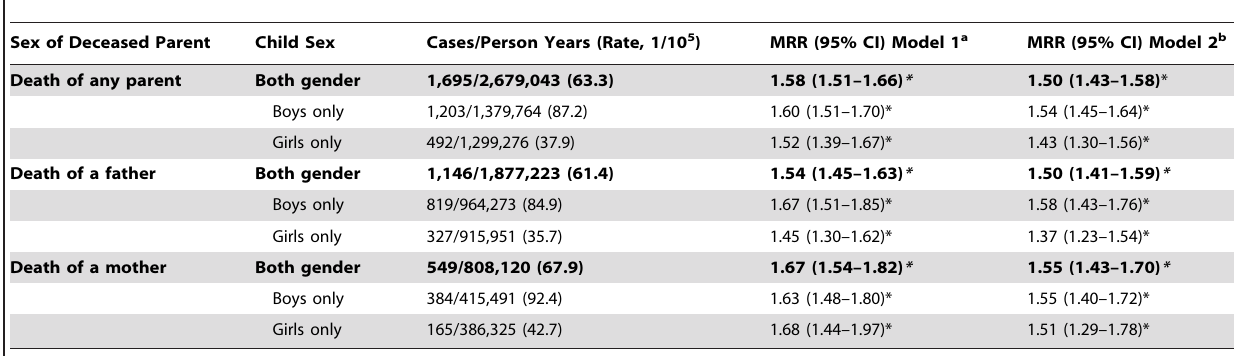
Table 3. Mortality rate ratios after parental death, according to sex of parent, sex of